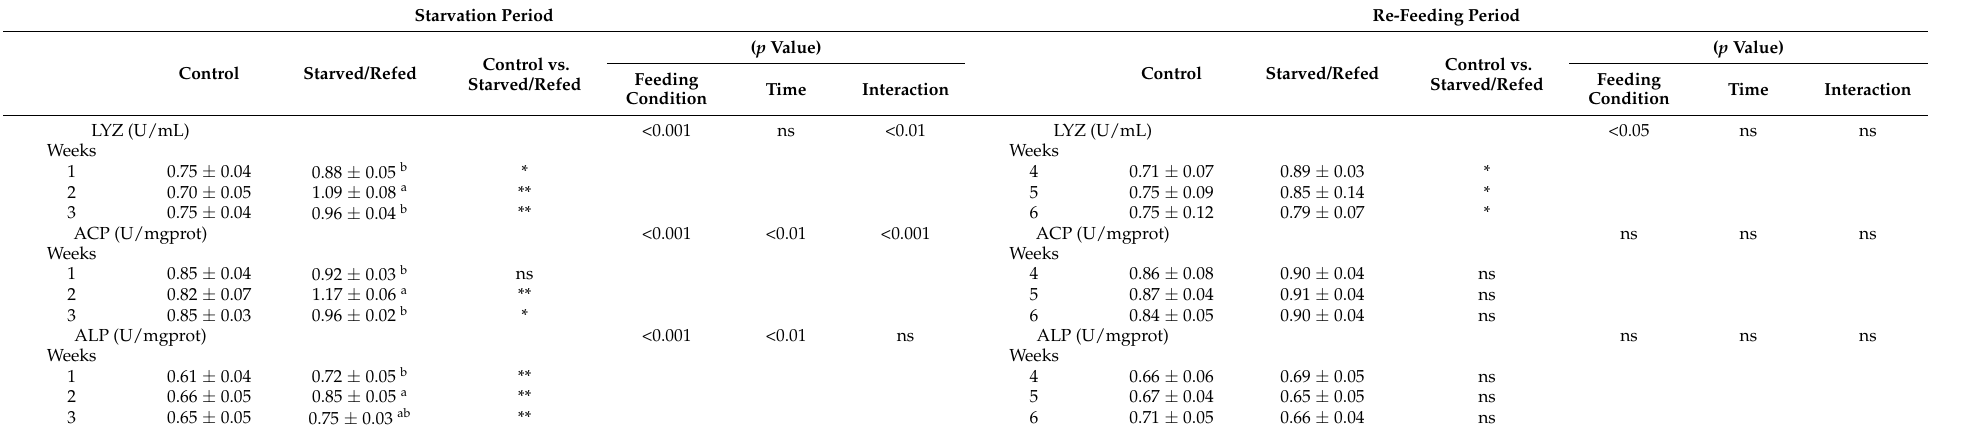
Table 6. Hepatic immune enzyme activities of O. macrolepis exposed to starvation and refeeding